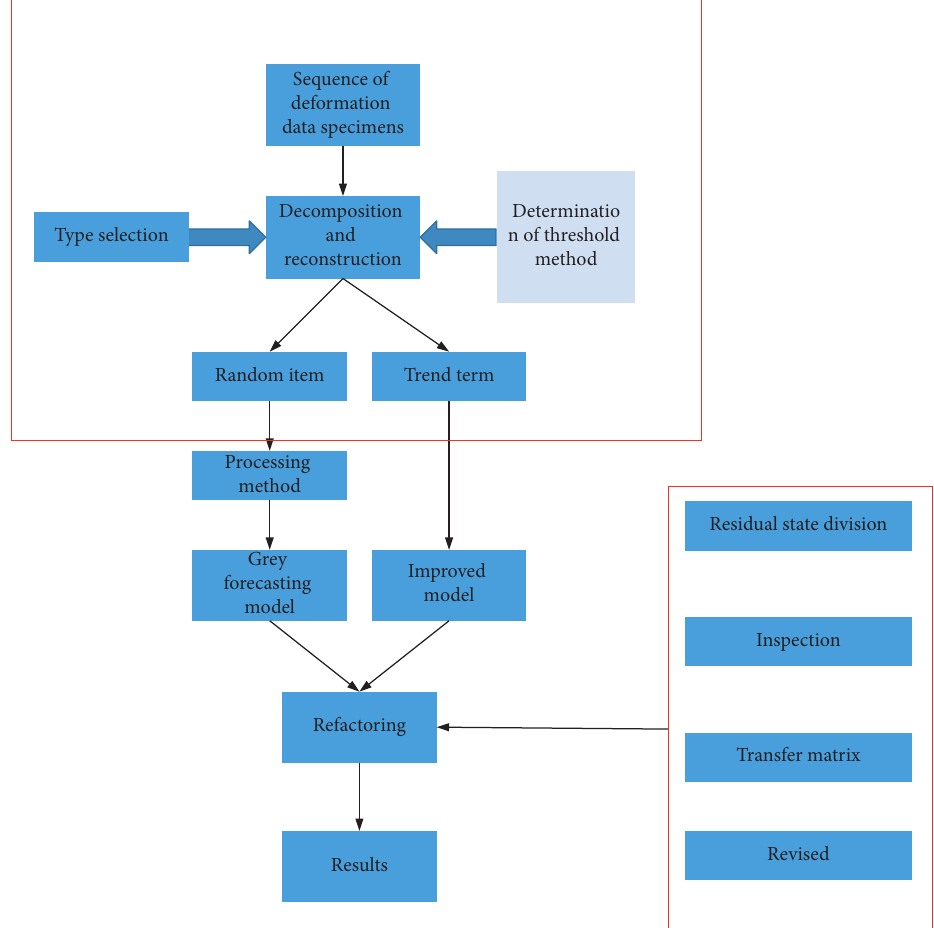
Figure 3: Calculation